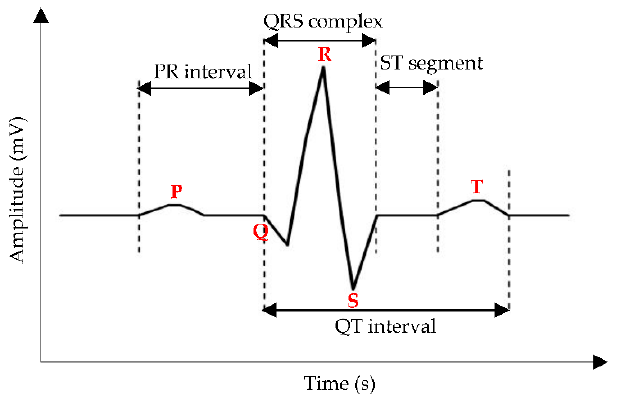
Figure 4. A common representation of the ECG waveform, where the red bold words indicate the P wave, the QRS complex, and the T wave. The measured distance between (1) onset of the P wave to the onset of the QRS complex, (2) offset of the S wave to the onset of the T wave, and (3) onset of the Q wave to the offset of the T wave, are labelled as PR interval, ST segment, and QT interval, respec- tively.